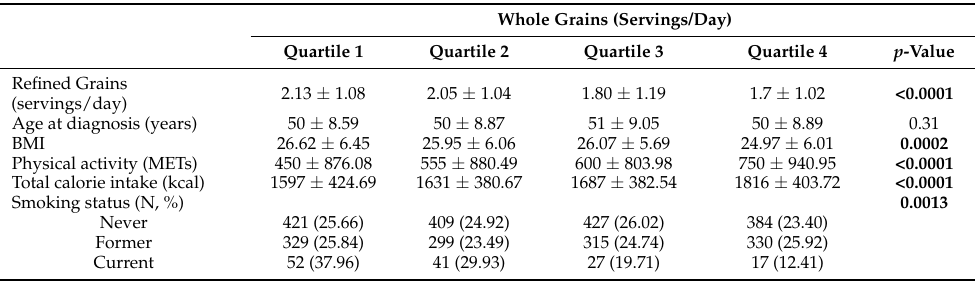
Table 2. Baseline characteristics of breast cancer survivors by quartiles of the baseline whole grain